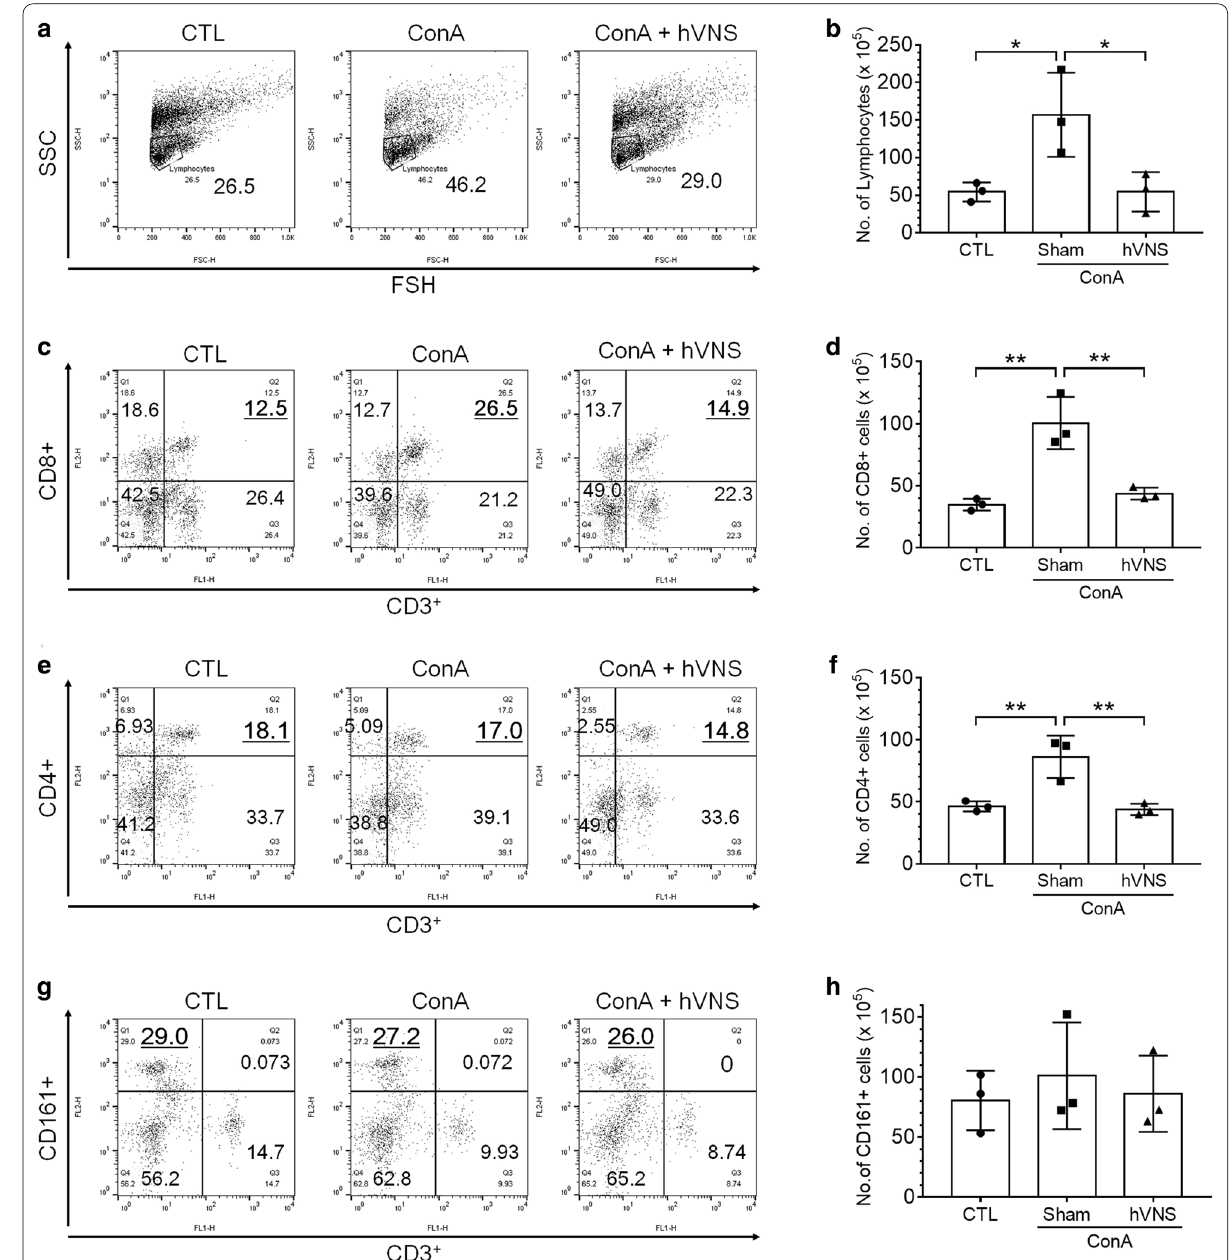
Fig. 4 Down‑regulation in infiltration of CD8 + and CD4 + lymphocytes by hVNS in Con A‑injected animals. Flow cytometry analysis were gated on FSH vs. SSC for lymphocyte ( a , b ), CD3 + and CD8 + for CD8 + T cells ( c , d ), CD3 + and CD4 + for CD4 + T cells ( e , f ), and CD3 + and CD161 + for NK cells ( g , h ). Quantification of absolute cell numbers was plotted and compared among experimental groups ( b , d , f , h ). The underlined numbers in the quadrants in c , e , g denote the percentage of target cells used for counting. In all plots in b , d , f , h ), one‑way ANOVA with Tukey post hoc is shown. *p < 0.05, **p < 0.01 (n =